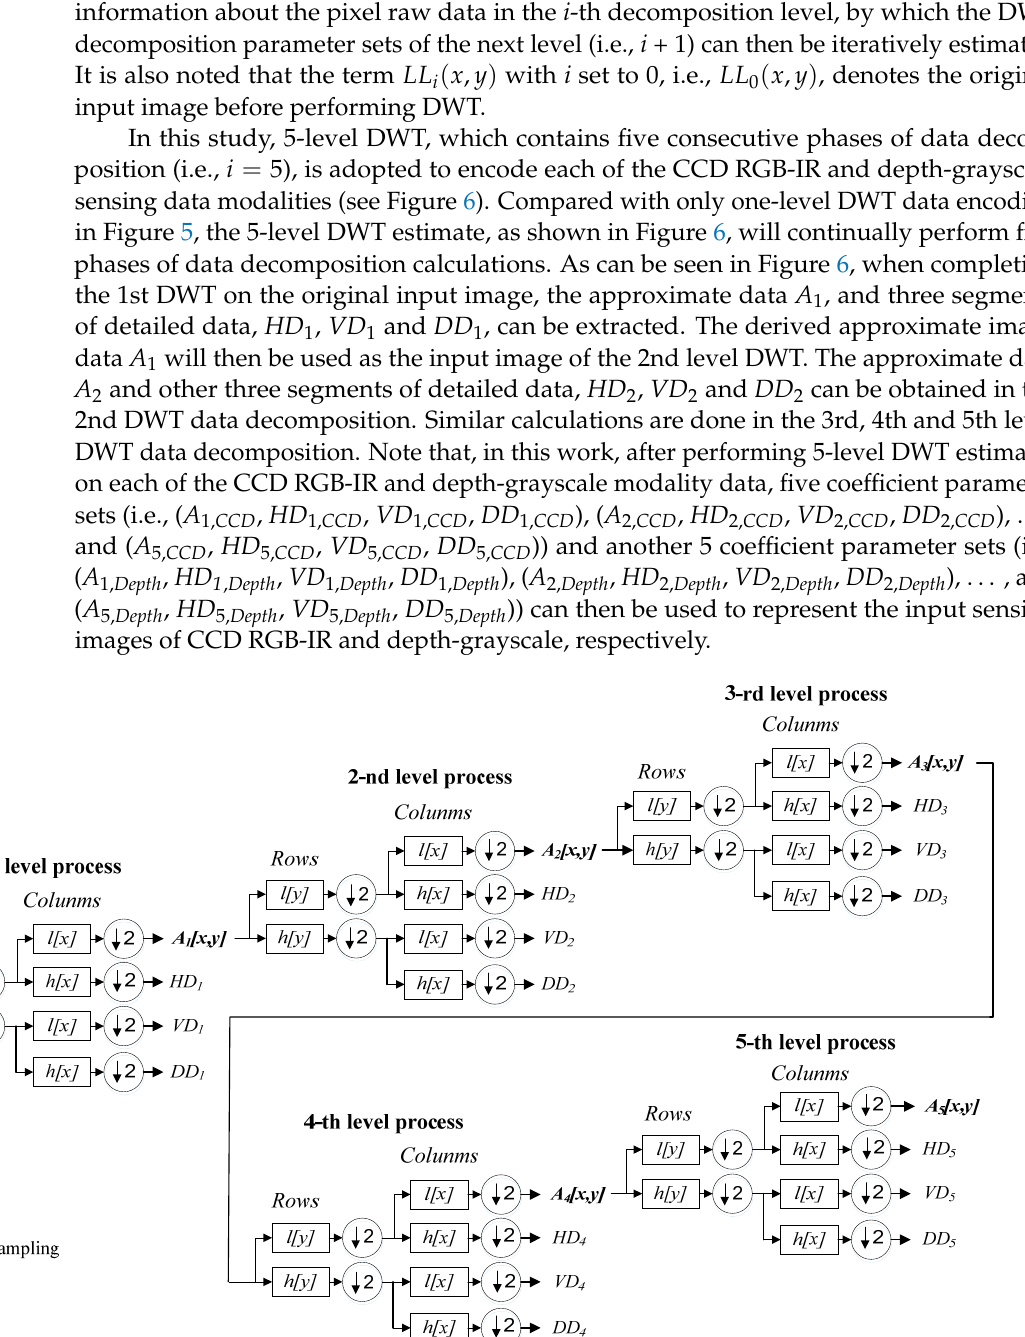
Figure 7. Coefficient derivation process of 5-level DWT decomposition on sensing data of the CCD RGB-IR modality of the hand gesture action.